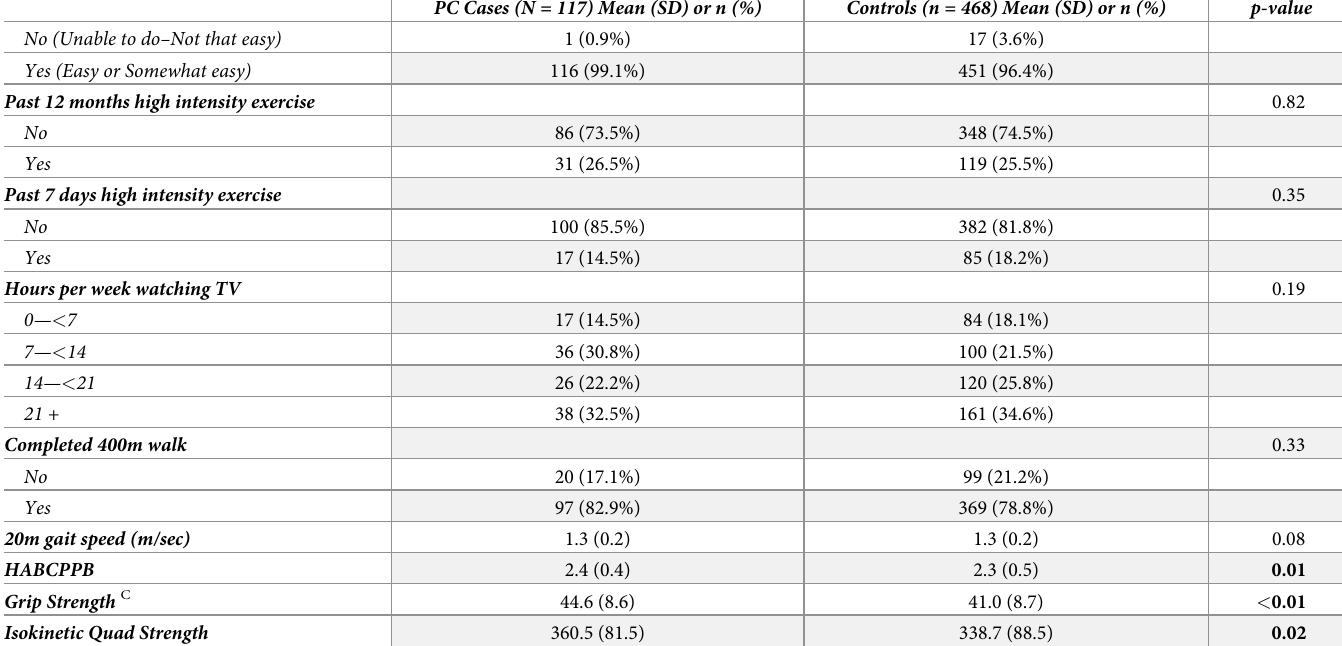
Fig 2 (panel A-E) shows the group-based trajectories of change in strength and physical function, from pre- to post-diagnosis. Plot A shows a different pattern in the trajectory of grip strength for cases compared with controls. In controls, grip strength declines by